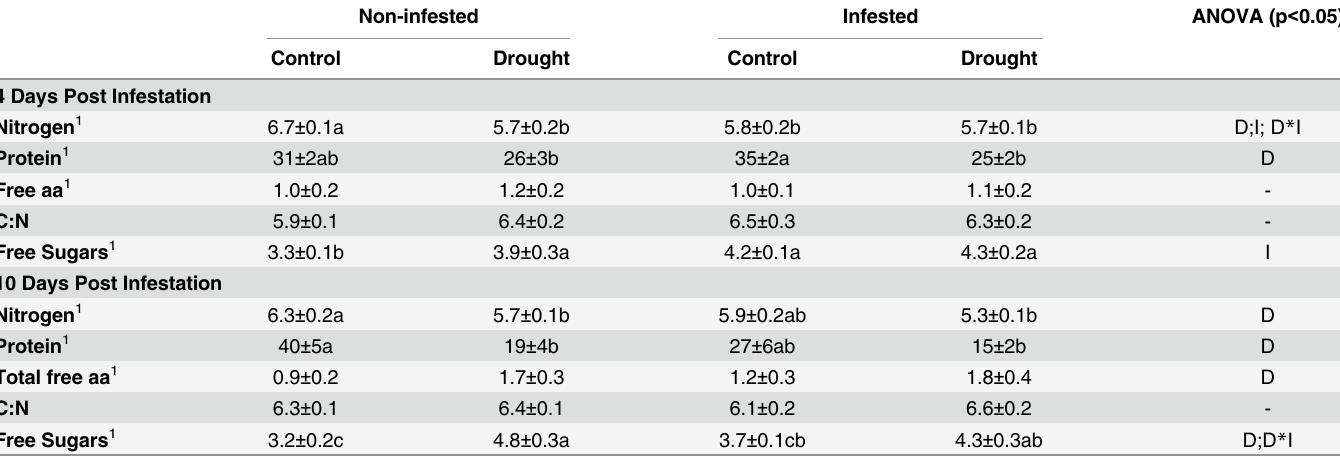
Table 1. Effect of moderate drought and T . evansi infestation on key nutrients in tomato leaves at 4 and 10 days post infestation.